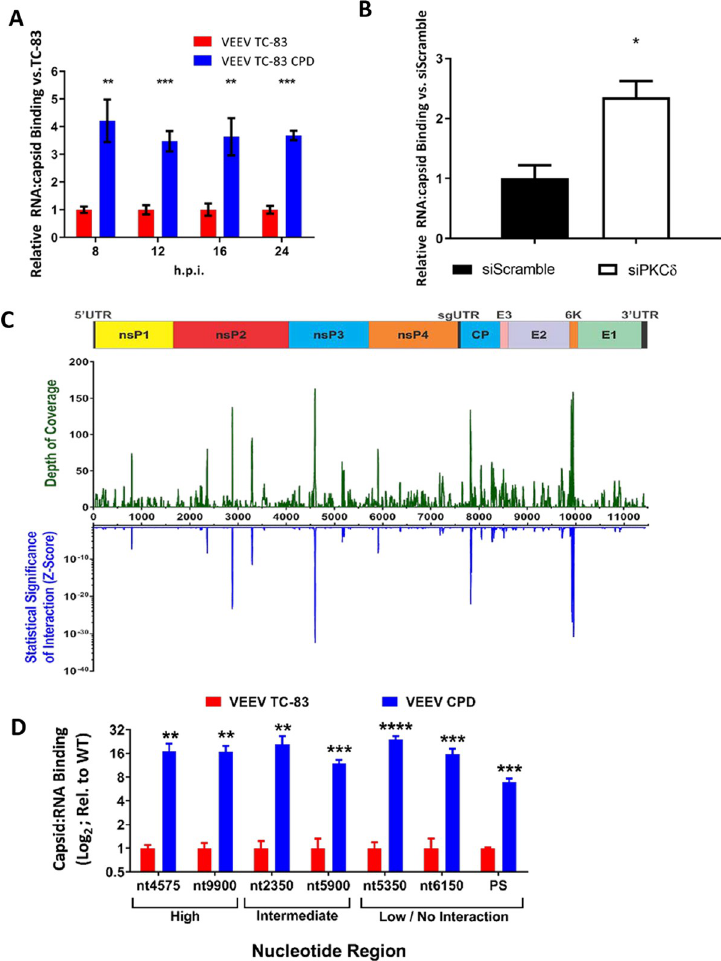
Fig 7. VEEV CPD binds RNA more efficiently than VEEV TC-83. A) Vero cells were infected with VEEV TC-83 or VEEV CPD (MOI 1.0). Cells were collected at the indicated time points, cross-linked, and cell lysates were immunoprecipitated with either α -HA or α -VEEV capsid antibodies. RT-qPCR against the VEEV packaging signal was performed on RNA isolated from immunocomplexes and normalized relative to a VEEV RNA standard curve generated during the same reaction. Genomic copies per reaction from α -HA immunoprecipitated samples were subtracted from the associated genomic copies from α -capsid immunoprecipitated samples to remove background and then the % RNA bound to capsid was determined by dividing the genomic copies from the input RNA by the normalized immunoprecipitated RNA. RNA:capsid binding of VEEV CPD was normalized relative to VEEV TC-83 samples. B) U87MG cells were transfected with 50 nM scramble control or PKC δ siRNAs. Seventy-two hours post- transfection, cells were infected with VEEV TC-83 (MOI 1.0). Samples were collected at 16hpi and processed in the same manner as panel A. C) A graphical representation of the VEEV Capsid CLIP-Seq data. On the Y-axes are the mean depths of coverage for the VEEV anti-Capsid data sets (Top) and relative statistical significance (Bottom) plotted with respect to nucleotide position (X-axis). Shown above the graphs is a schematic representation of the VEEV TC-83 reference genome (drawn to scale with the X-axis). D) Vero cells were infected with VEEV TC-83 or VEEV CPD (MOI 1.0). Cells were collected at 16 hpi, cross-linked, and cell lysates were immunoprecipitated with either α -HA or α - VEEV capsid antibodies. RT-qPCR against the VEEV canonical packaging signal and the sites identified in panel C was performed on RNA isolated from immunocomplexes and normalized relative to a VEEV RNA standard curve generated during the same reaction. Data analysis was performed as described in panel A. Data is average of 3 biological replicates. � = p < 0.05, �� = p < 0.005, ��� = p < 0.0005, ���� = p <